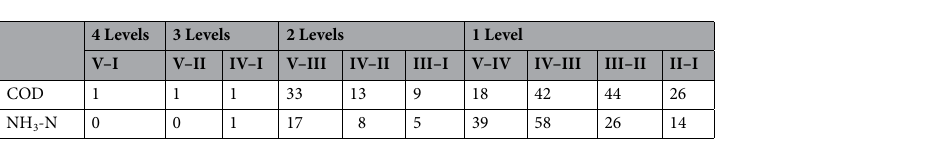
Table 2. Changes in pollutant emission